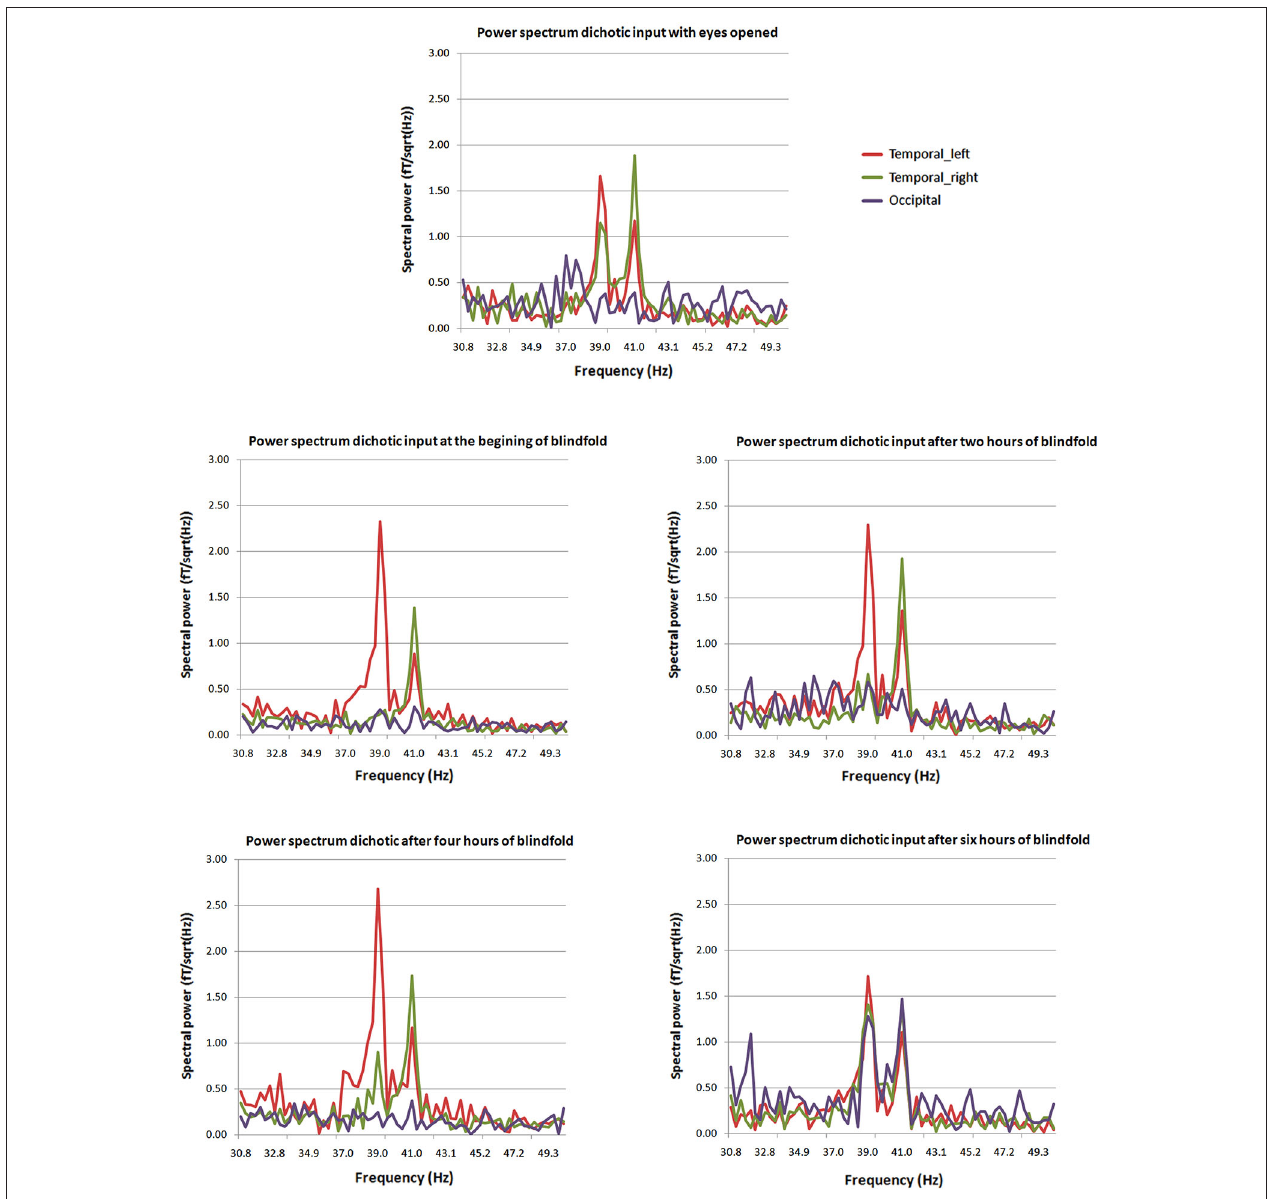
not seen clearly in previous measures. Mean average spectral peaks for the regular ASSR with eyes opened for comparison purposes are presented at the top of the figure (Lazzouni et al.,